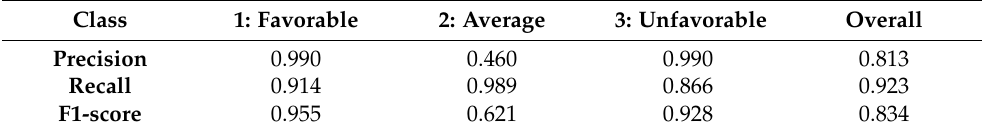
Table 7. Results of statistical criteria (precision, recall, F1-score) to evaluate the HMP-Coffee proposed to estimate three profitability levels/classes: Favorable, Average and Low. The Overall contains the average by statistical criteria. Class 1: Favorable 2: Average 3: